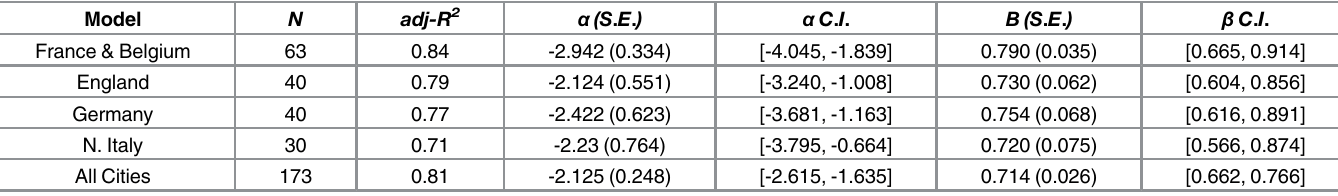
Table 1. Scaling of Settlement Area with Population Size: ln(area) = α + β ln(population)